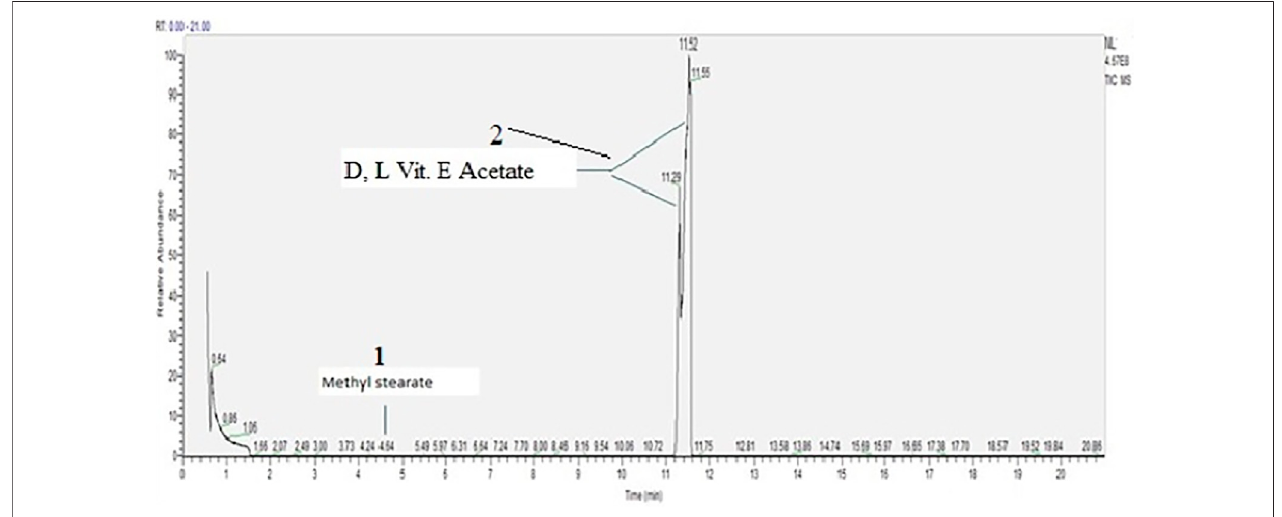
FIGURE 4 | D, L Vitamin E acetate scan, concentration 2000 µg/ml.